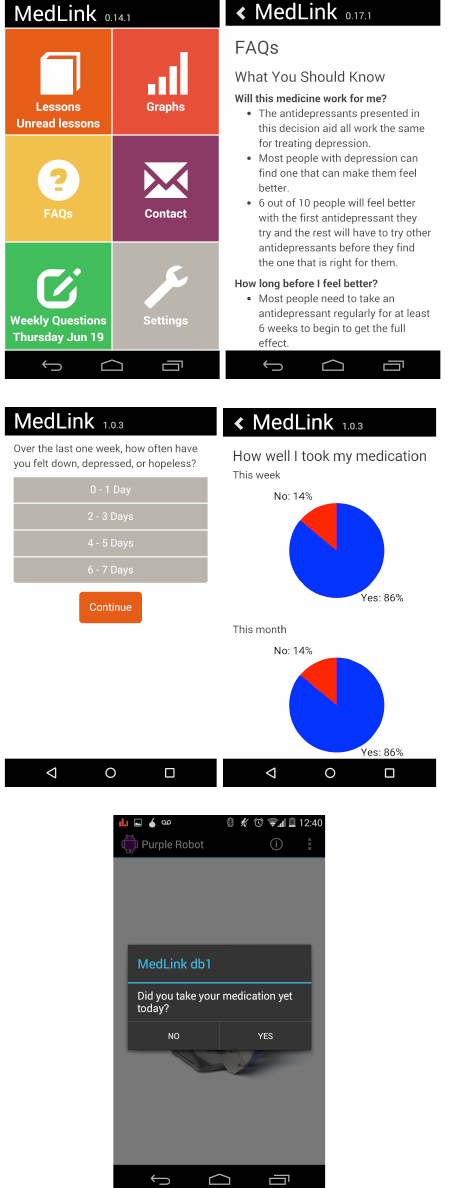
Fig. 2. MedLink Screenshots from top to bottom: Home Screen, Lesson, Assessment, Graphic Feedback, and Notification Each week the patient is notified to complete in-app assessments of depressive symptom severity using the